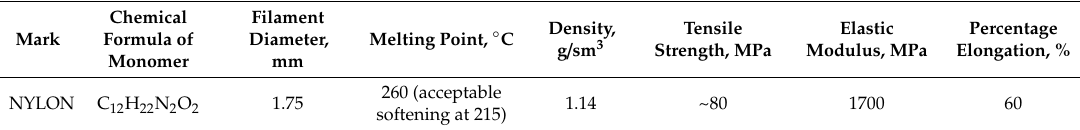
Table 1. Properties of NYLON